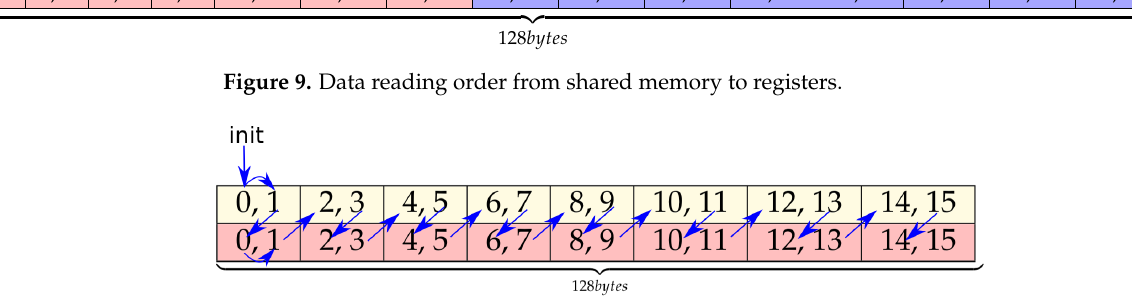
Figure 10. Order of the elements after replacing float4 elements by two float2